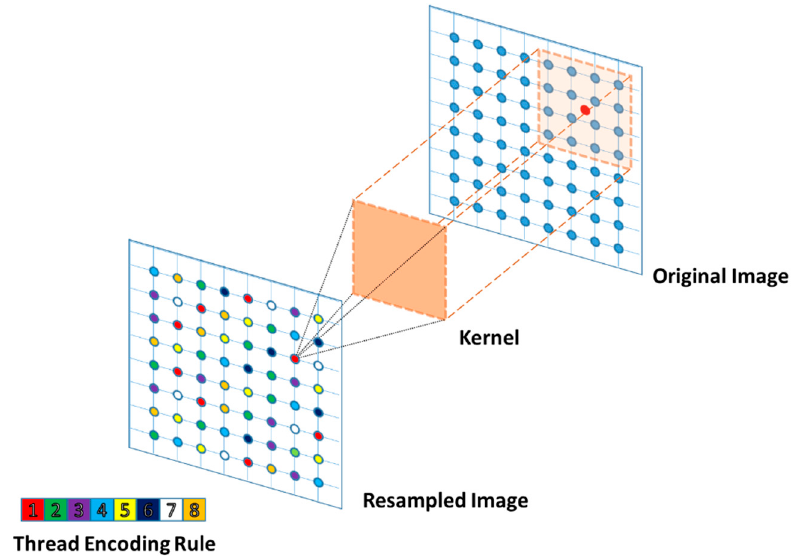
Figure 4. Parallel scheme of the reconstruction operation based on the convolution of the 2D image with a 2D interpolation kernel: different colors are associated with distinct threads in the pictorial representation.